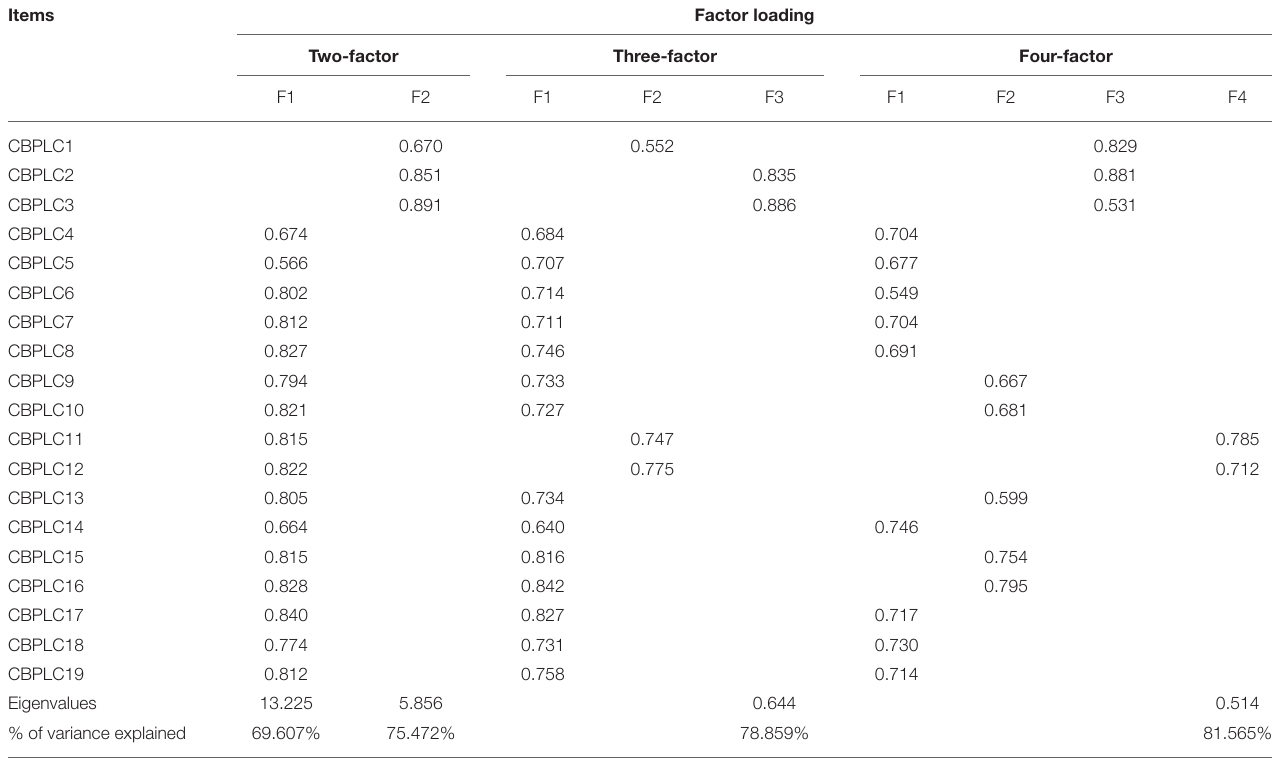
TABLE 2 | Results of the exploratory factor analysis on the CBPLC in sample A ( N = 1,410). Items